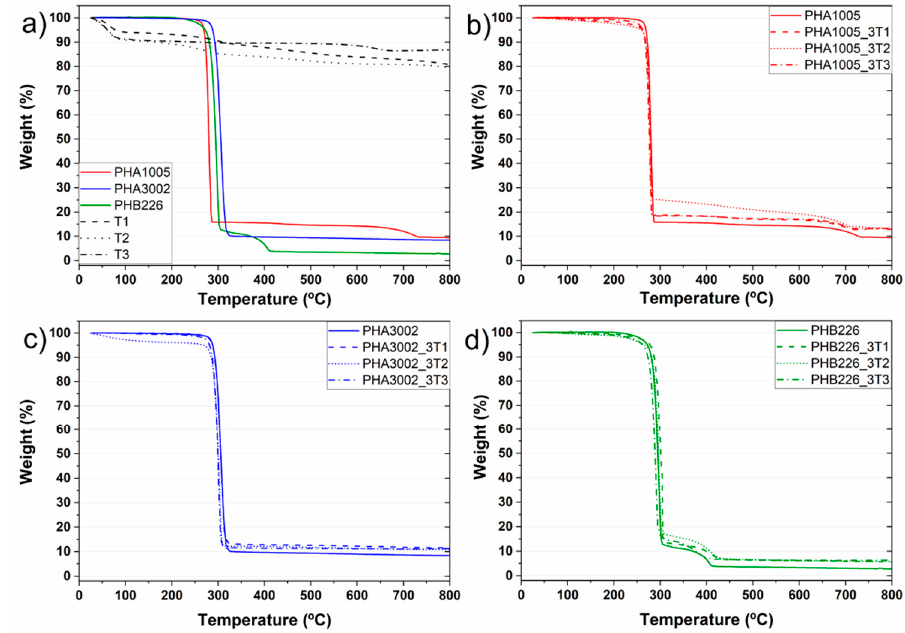
Figure 2. TGA curves: ( a ) neat matrices and nanoclays; ( b ) PHA1005 composites; ( c ) PHA3002 composites; ( d ) PHB226 composites.